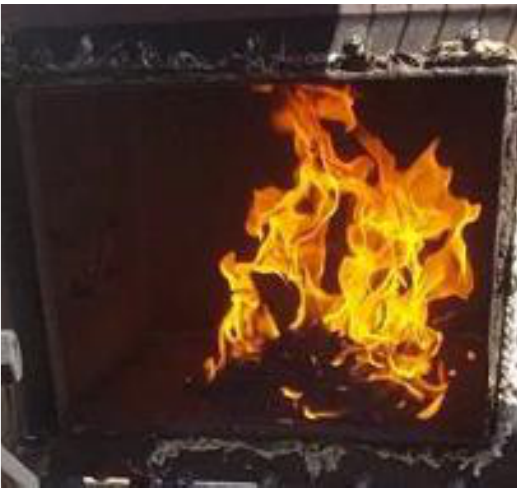
Figure 5. Igniting vegetation in the furnace of the ESS.